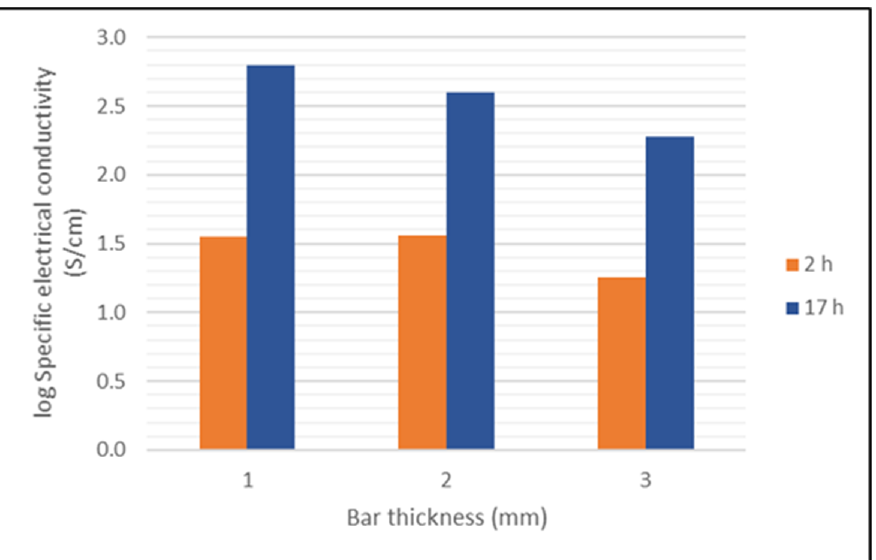
Figure 17. Specific electrical conductivity of titanium suboxide testing bars after sintering following the regime given in Table 2 with two different holding times at the transition temperature depending on the thickness of the bars.